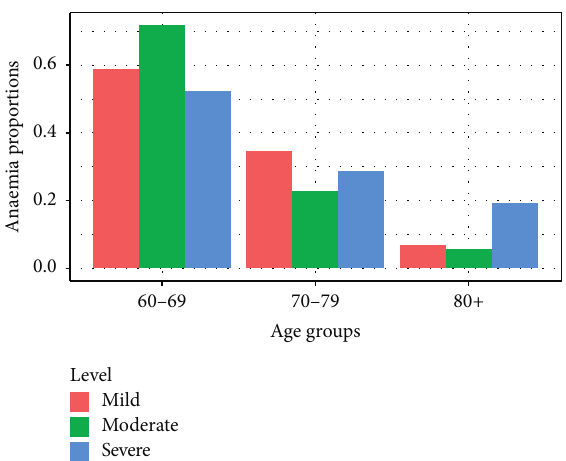
Figure 3: Severity of anaemia with age